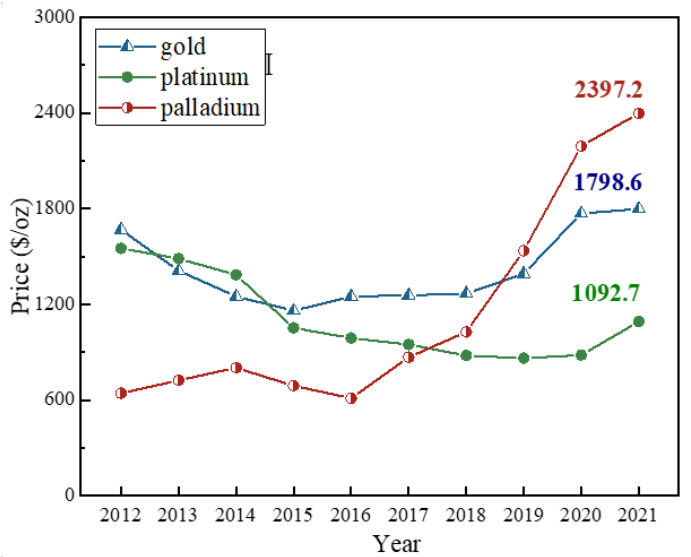
Figure 1. The price tendency of gold, platinum, and palladium from the year 2012 to 2021. The great consumption of palladium products leads to a great amount of waste and scrap containing palladium. Recovery of palladium from the spent automobile